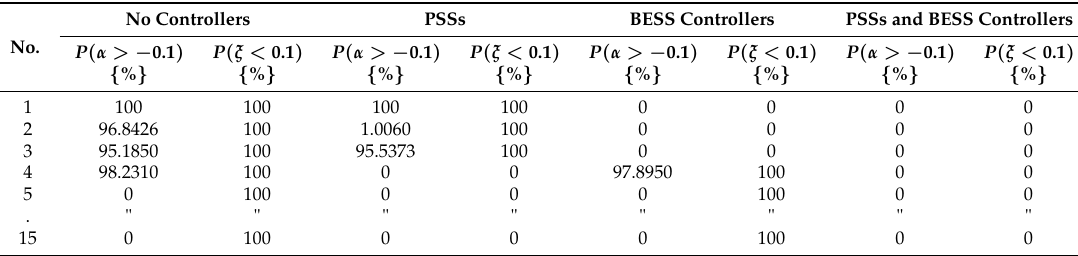
Stability indices under different controller conditions for Scenario 3 using the proposed